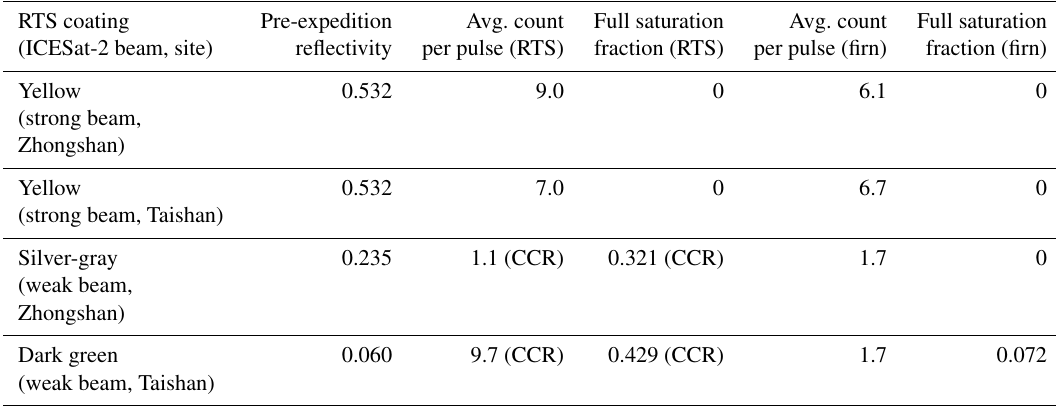
Table 3. Received photons and full saturation fractions (FSFs) with respect to different RTS coatings. RTS coating Pre-expedition Avg. count (ICESat-2 beam, site)